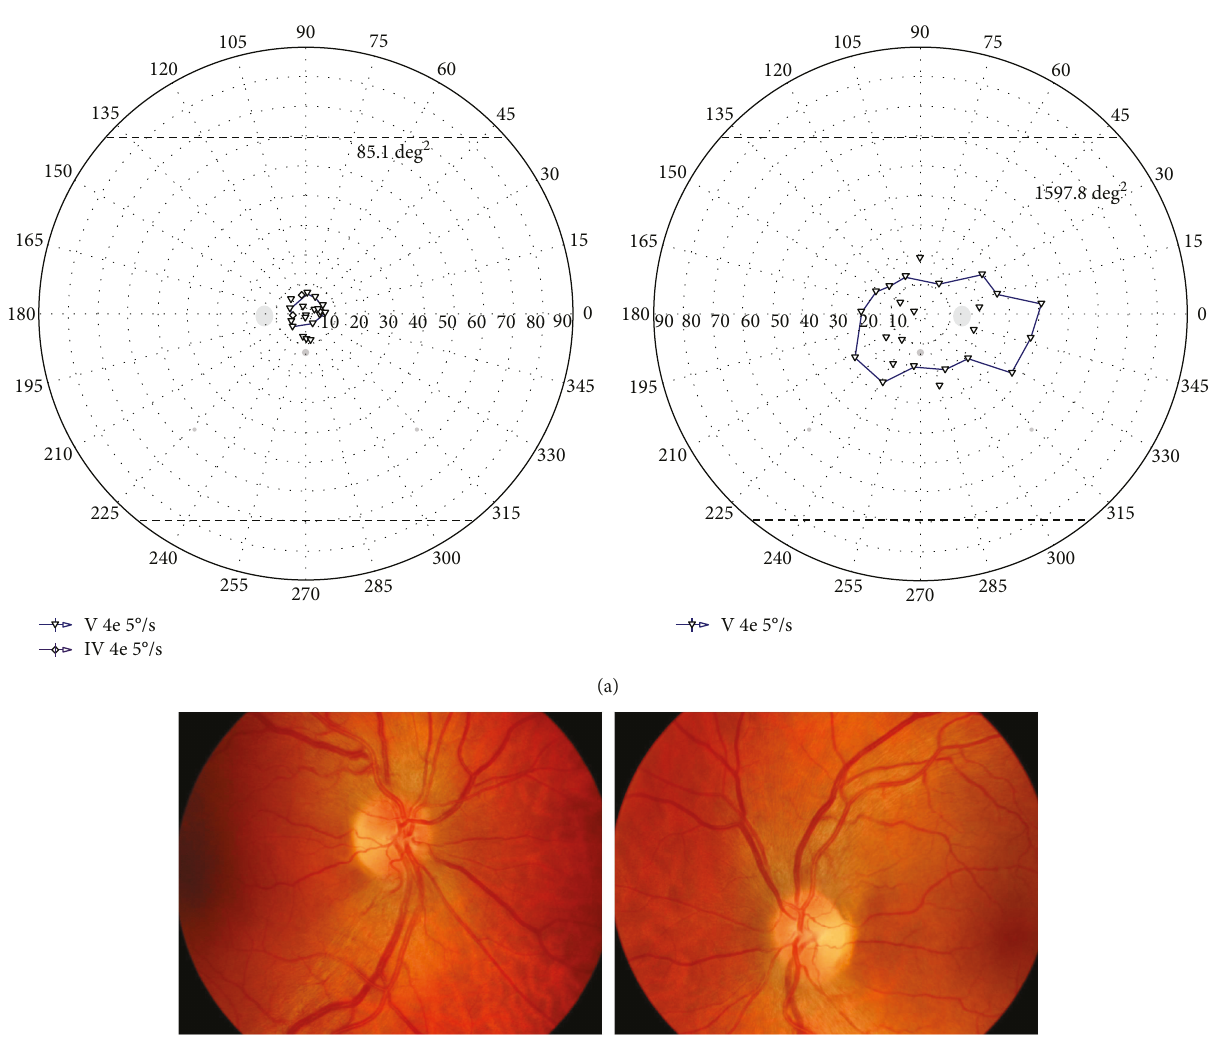
Figure 2: Illustrative case of LHON patient with residual central island of vision. (a) Visual fi eld result of both eyes (right eye on the right and left eye on the left) obtained with semiautomated kinetic perimetry and V4e stimulus moved with the speed of 5 degrees per second in patient with LHON. Visual acuity was counting fi ngers to one meter in both eyes. Central residual visual fi eld measured in square degrees (deg 2 ). Static automated perimetry was not obtained due to poor visual acuity. (b) Fundus pictures (right eye on the left and left eye on the right) of patient number 10 showing swelling of the retinal nerve fi bers involving the superior and inferior arcades around the optic